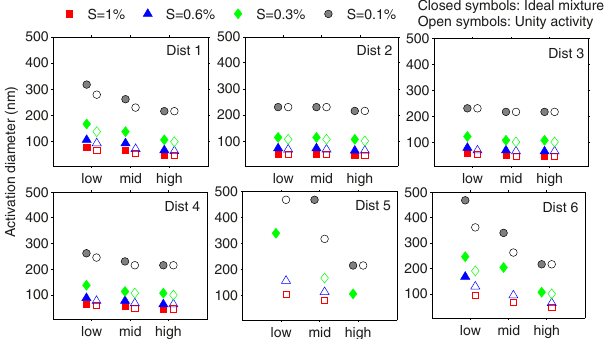
Figure 4. The dependence of the activation diameter for four differ- ent supersaturations ( s = 1, 0.6, 0.3 and 0.1%; see also Fig. 3b) on the solubility range for the solubility distributions outlined in Ta- ble 2 for n = 5, and the two assumptions about the organic-phase